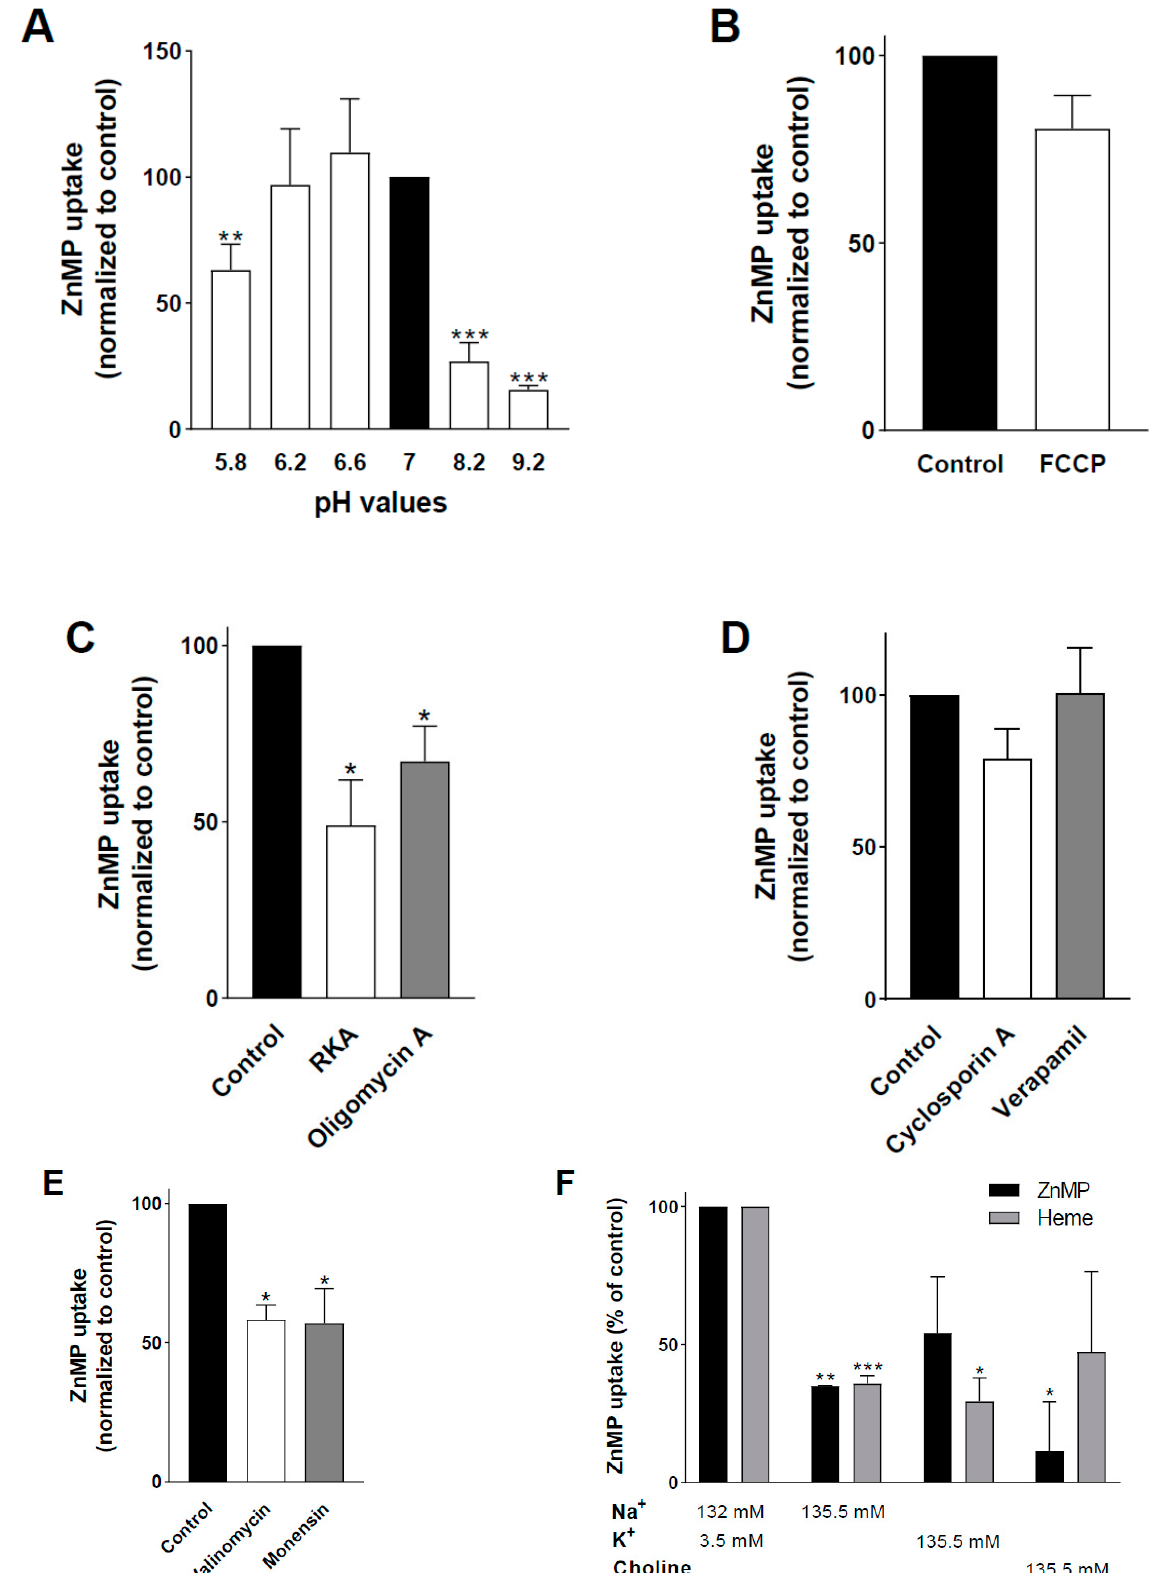
Figure 2. Analysis of the driving force of porphyrin import in L. major promastigotes . ( A ) ZnMP